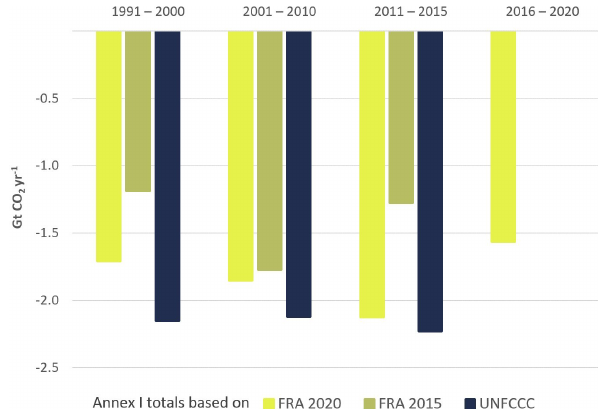
Figure 5. Comparison of estimates of emissions/removals on forest land (FL) for Annex I totals in GtCO 2 yr − 1 , based on FRA 2020 (acid green) and FRA 2015 (olive green), to the Annex I totals re- ported by countries to the UNFCCC (cadet